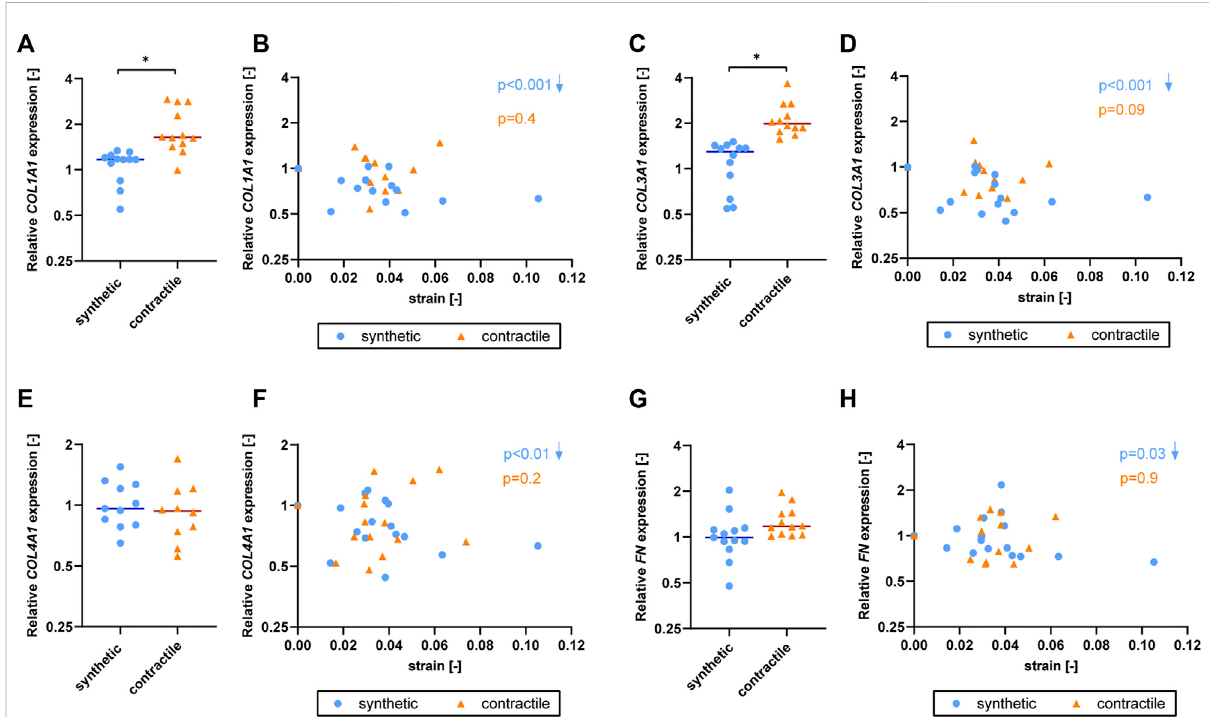
FIGURE 7 The effect of strain on ECM for synthetic and contractile VSMCs. Gene expression of ECM components (A,B) COL1A1 , (C,D) COL3A1 , (E,F) COL4A1 and (G,H) FN for synthetic (blue circles) and contractile (orange triangles) VSMCs (A,C,E,G) in the absence of strain (normalized to the syntheticcontrol)and (B,D,F,H) asafunctionofstrain(eachdatapointisnormalizedtoitscorrespondingstaticcontrolexpression). p valuesshowthe signi fi cancelevel of non-parametric Spearman correlation coef fi cient. The arrows next to signi fi cant correlations ( p < 0.05 )demonstrate an up or downregulation in gene expression with applied strain